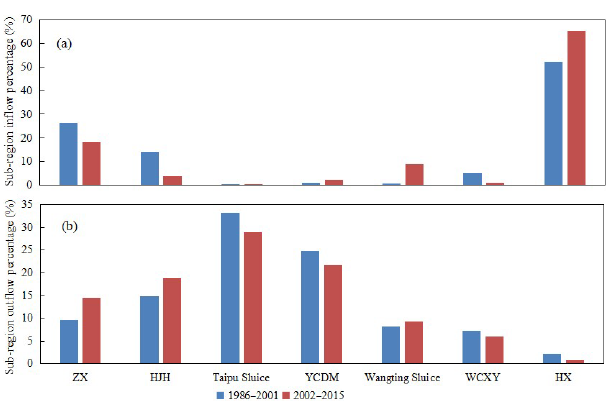
Figure 5. Multi-year average annual inflow (a) and outflow (b) per- centage of